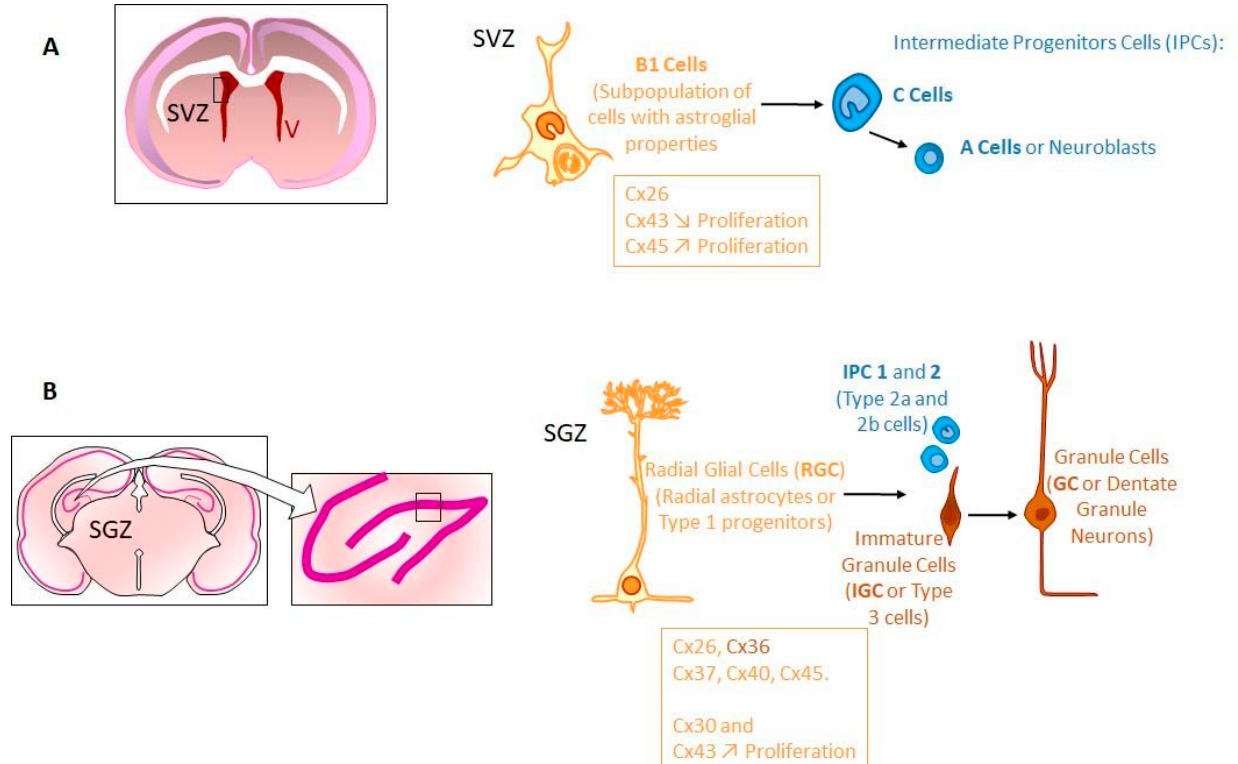
Figure 3. Stem cell niche and neurogenesis in adult. Neural stem cells (NSCs) are mostly retained in two regions: Sub- ventricular zone (SVZ) and sub-granular zone (SGZ). ( A ) Frontal cross-section of the adult brain showing the location of the SVZ, in walls of the lateral ventricles (V). In the SVZ, NSCs correspond to type B1 cells. B1 cells express Cx26, Cx43 and Cx45. While Cx43 expression negatively regulates cell proliferation, Cx45 exhibits an opposite role. These B1 cells generate intermediate progenitor cells (IPCs) corresponding to C cells that divide to generate neuroblasts (type A cells). ( B ) Frontal cross-section of the adult brain showing the hippocampal formation. The insert indicates the location of the dentate gyrus. The adult dentate gyrus contains radial glial cells, which are polarized cells with their cell body in the SGZ. Radial glial cells (RGC or RC, type 1 cells) generate IPCs (IPC1 and IPC2 or type 2a and type 2b cells), which differentiate into immature granule cells (IGCs or type 3 cells) and mature granule cells (GC). In SGZ, Cx26, Cx30, Cx36, Cx37, Cx40, Cx43, Cx45 are expressed in various NPCs. Interestingly, Cx30 and Cx43 seem to be active regulators of hippocampal NPC proliferation while Cx43 itself is a negative regulator of proliferation in SVZ [258].